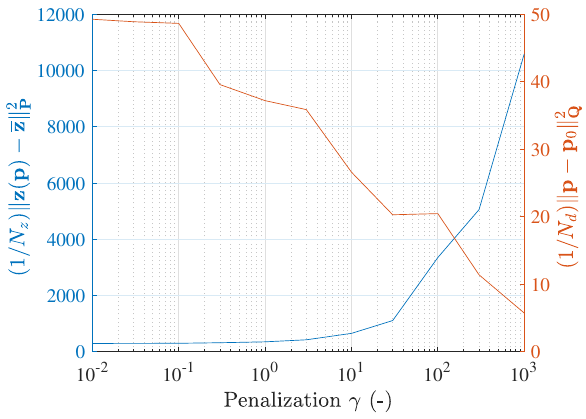
Fig. 5. Magnitude of the two different norms in the minimization problem (2) versus penalization.